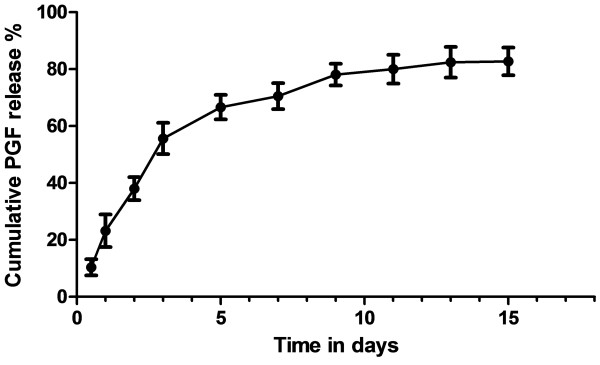

In vitro
cumulative release curve of PGF-PLGA
NPs
nanoparticles.